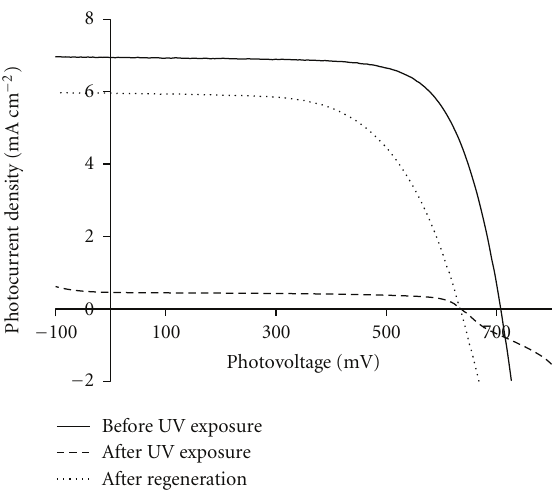
Figure 10: I-V curves of a typical photodegraded DSC cell before UV exposure, after UV exposure, and after electrolyte regeneration